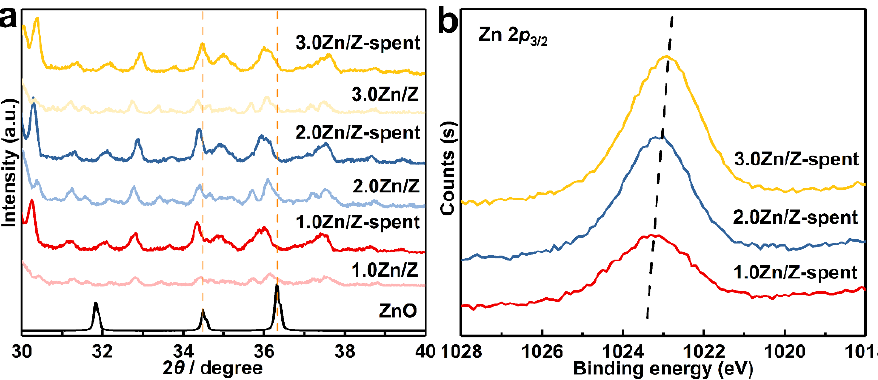
Figure 3. X−ray diffraction (XRD) patterns in range of 30–40° ( a ) and XPS spectra of Zn modified Figure 3. X − ray diffraction (XRD) patterns in range of 30–40 ◦ ( a ) and XPS spectra of Zn modified ZSM-5 samples after reaction ( b ). ZSM-5 samples after reaction ( b